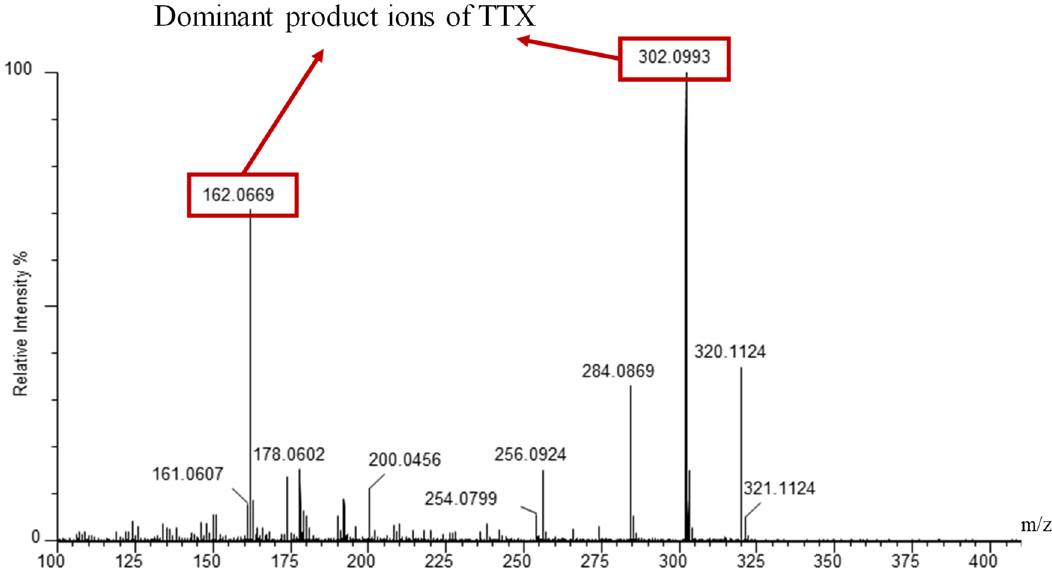
Figure 1. Mass spectra of product ions of TTX in standard solution (2000 µ g/L) analyzed by UPLC- QTOF in MS/MS mode with a Waters ACQUITY UPLC BEH Amide